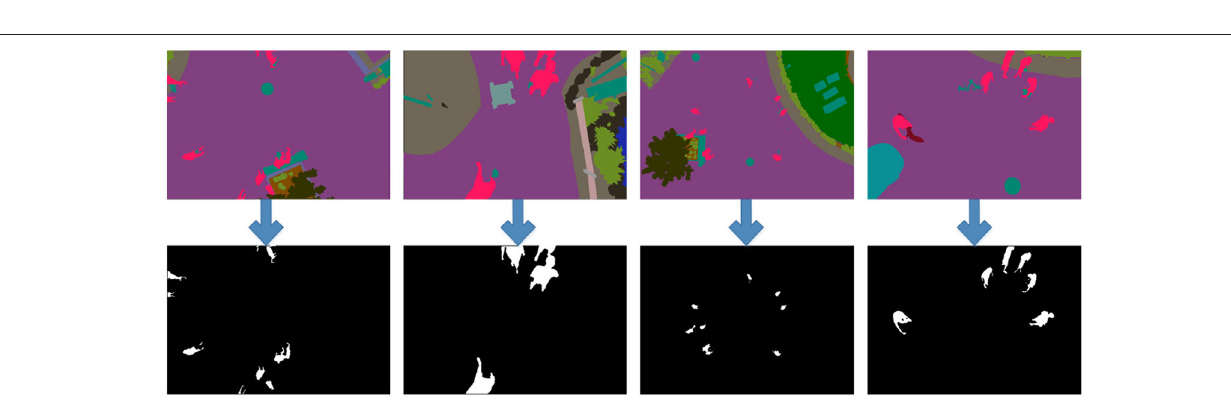
segmentation has attracted increasing attention in recent